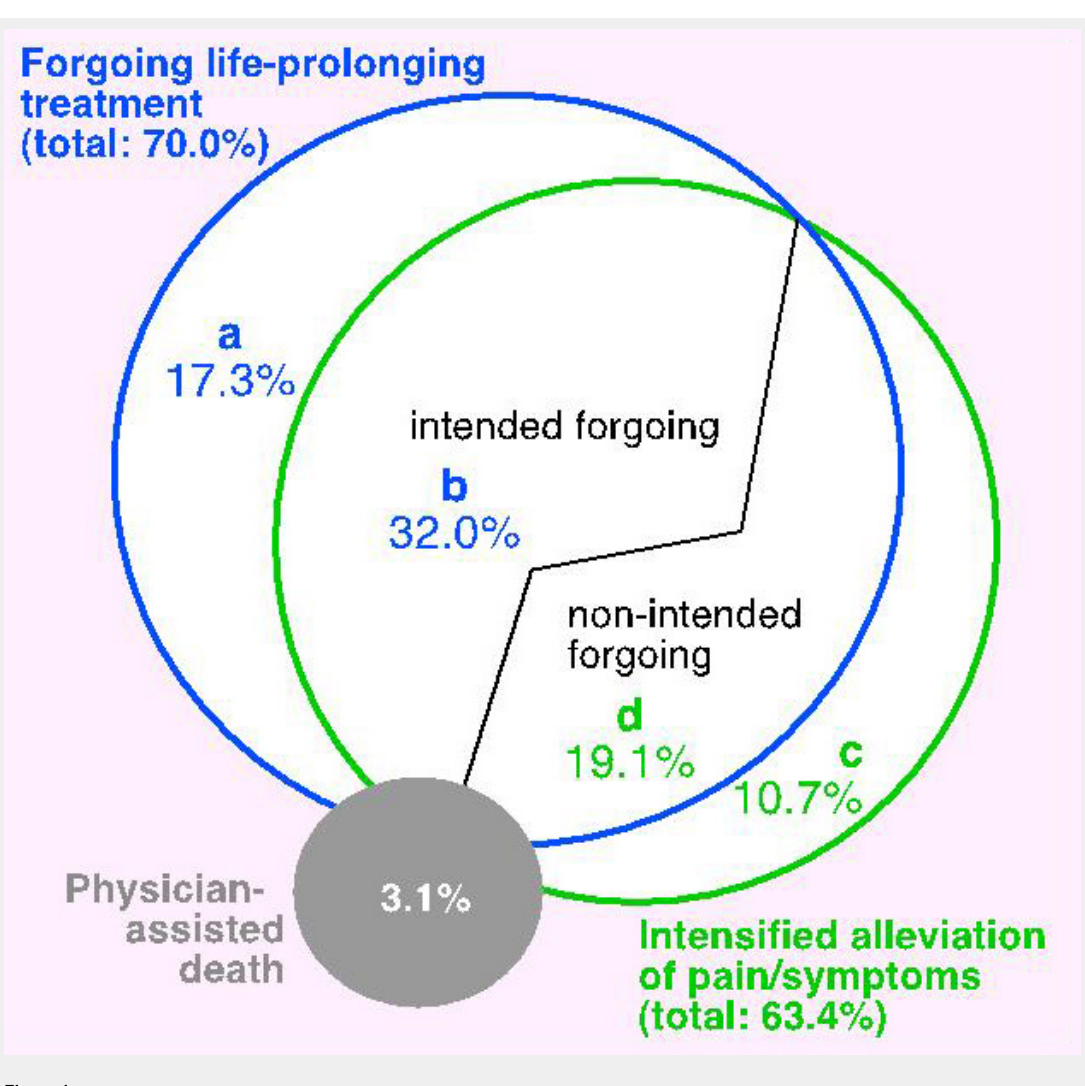
Overlap of different medical end-of-life practices, and categorisation as most important practice, German-speaking part of Switzerland 2013. 100% = all nonsudden expected deaths (n = 2256). All percentages are weighted. For categorisation as the most important end-of-life practice, (a) plus (b) were categorised as forgoing life-prolonging treatment, (c) plus (d) were categorised as intensified alleviation of pain and symptoms (see also table 2); physician-assisted death was always categorised as the most important